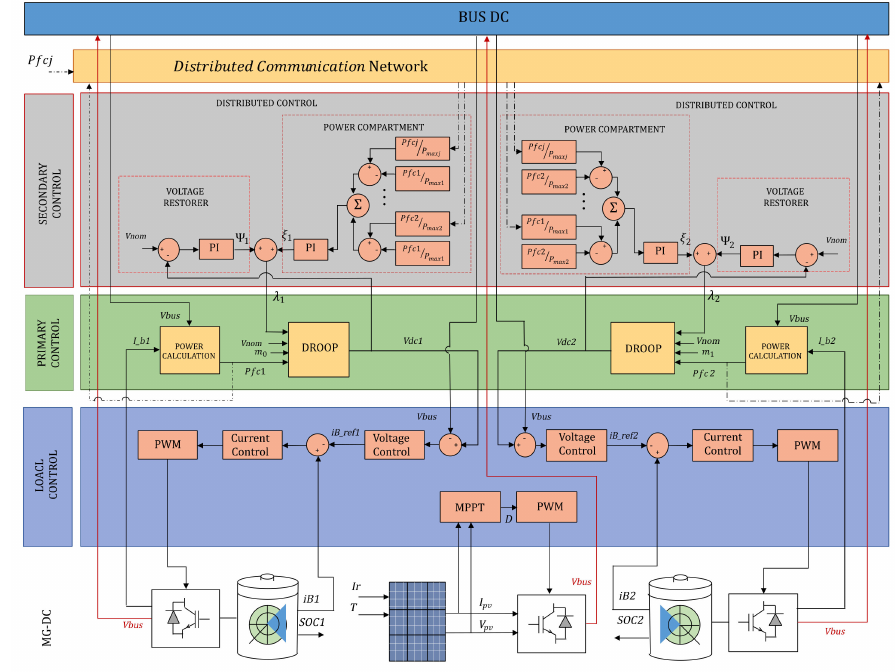
Figure 3. Control